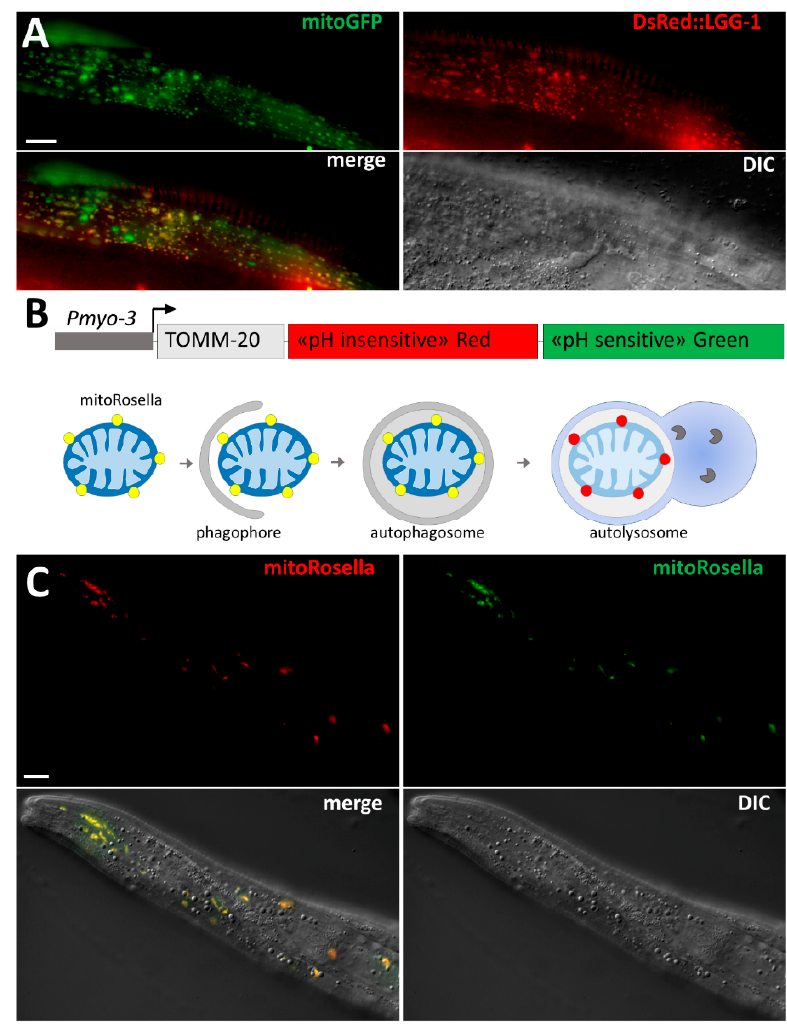
Figure 2. Tools for the study of mitophagy in C. elegans . ( A ) In vivo confocal images of mitophagy in the body wall muscle cells of an adult worm. After heat stress (37 ◦ C for 2 h), mitophagy is visualized by co-localization between fragmented mitochondria (mitoGFP in green) and autophagic structures (DsRed::LGG-1); ( B ) Schematic diagram of mitoRosella fluorescent protein biosensor under the control of the muscle-specific promoter myo-3 . MitoRosella is a chimeric protein-containing fragment of TOMM20, which leads to mitochondrial localization, the pH-stable DsRed fluorescent protein, and the pH-sensitive GFP. During mitophagic flux, mitochondria turn from yellow (DsRed and GFP) to red in autolysosome, due to the quenching of the GFP signal; ( C ) Confocal images of mitoRosella in body wall muscle cells of an adult worm in standard condition (20 ◦ C). All mitochondria are fluorescent for GFP and DsRed, indicating that the basal level of mitophagy in muscle is very low. Scale bar = 10 µm.